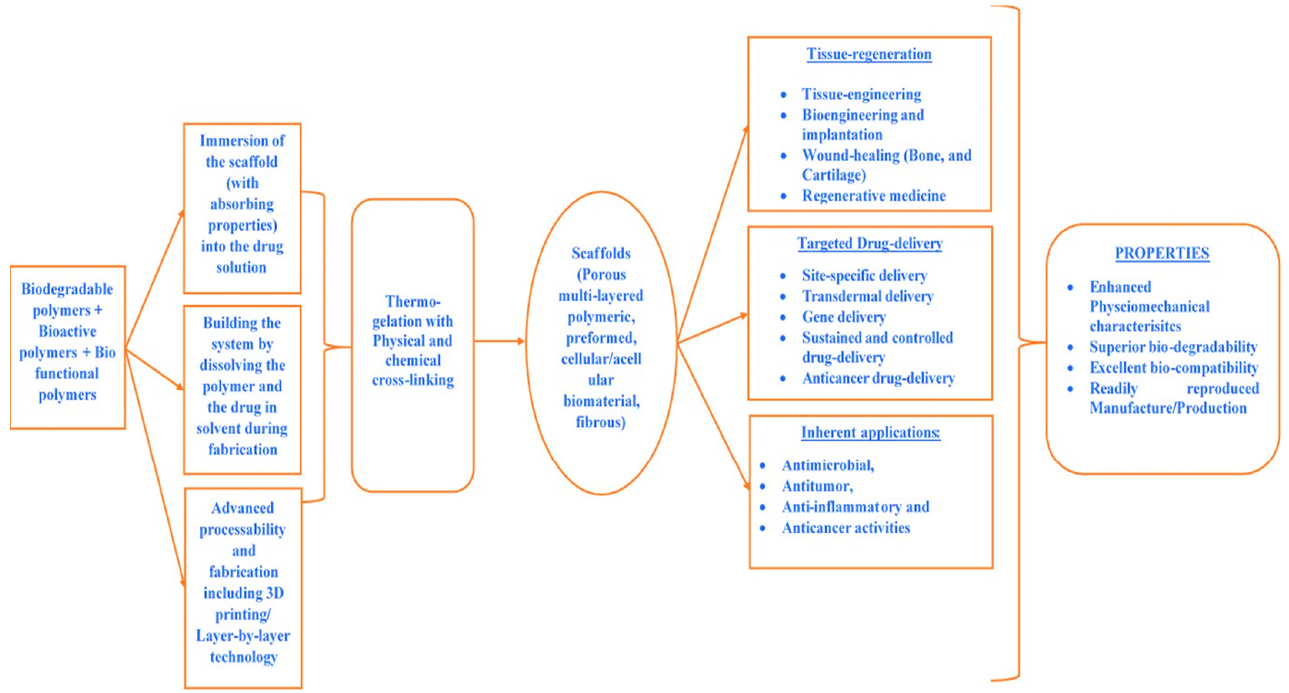
Figure 14. Visualization summarizing the numerous potentially attractive characteristics of biodegradable/bioactive polymerics for biomedical applications.